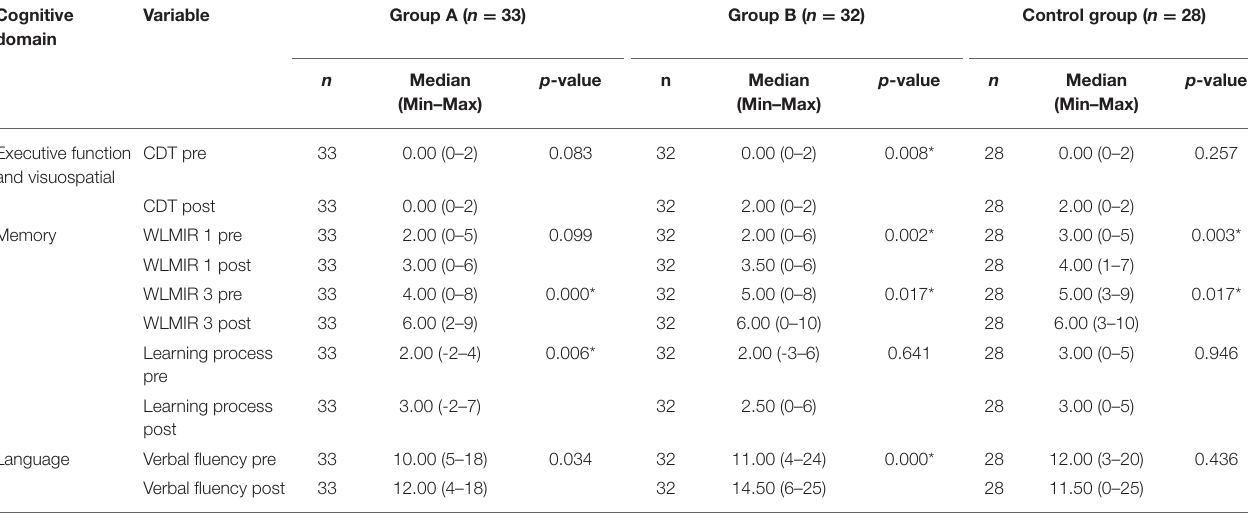
TABLE 4 | Cognitive score differences between group A, B, and